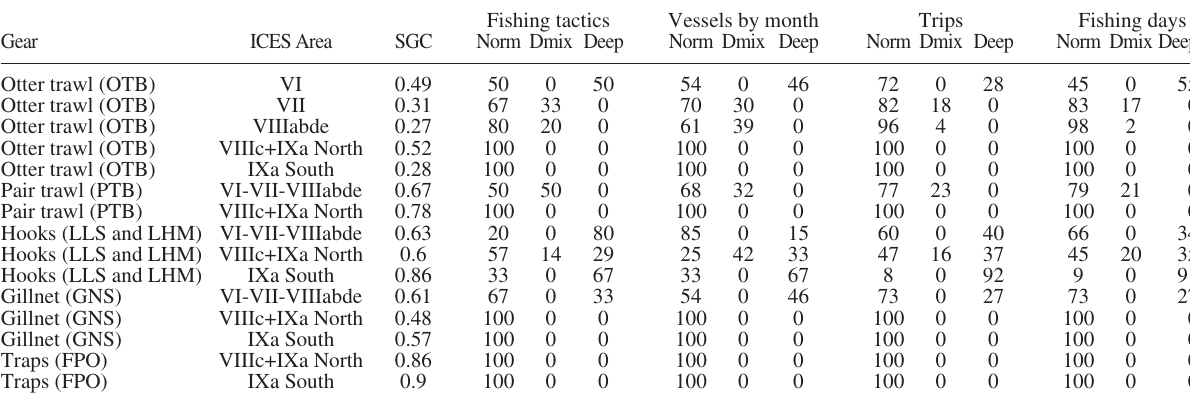
Table 1. – Relative importance of deep-sea fisheries compared to all other fisheries (per gear and zone) (SGC, silhouette global coefficient; Norm. No deep water fishing tactic; Dmix, demersal and deep-water fishing tactic mix; Deep, deep-water fishing tactic).